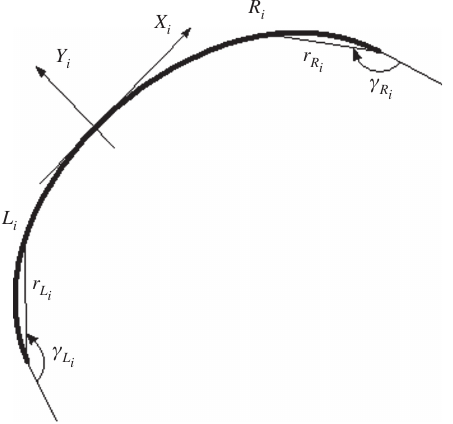
Figure 4 Local coordinates on the crack